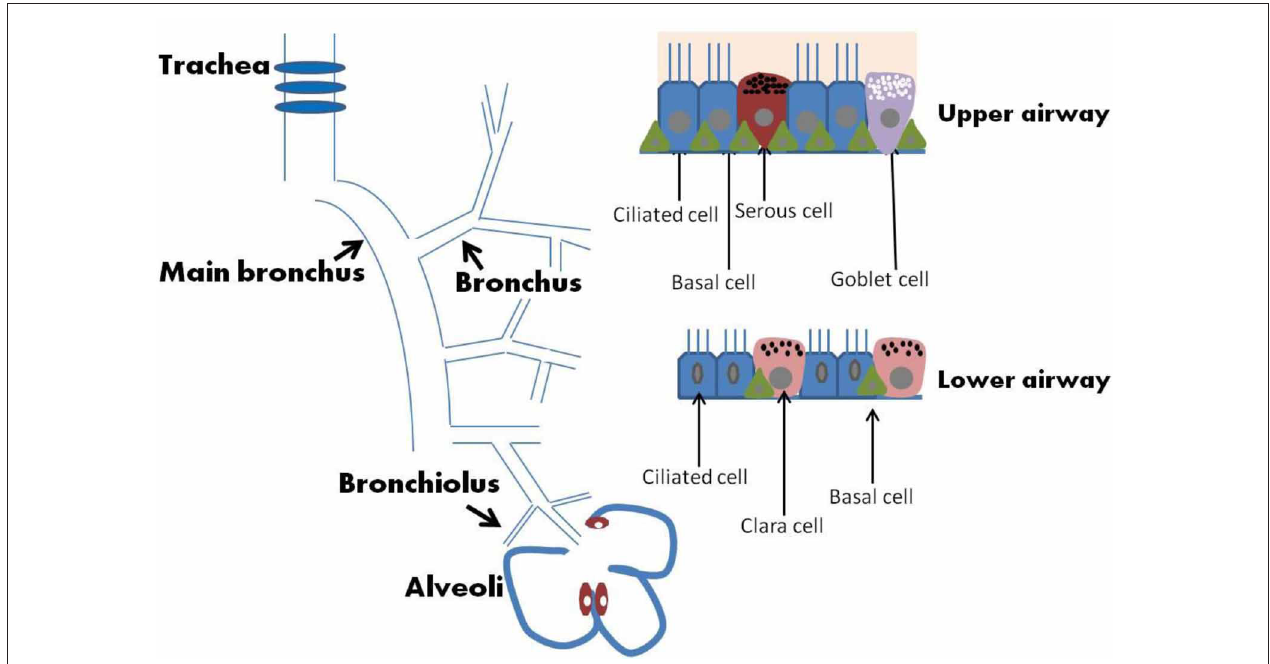
FIGURE 1 | Airway and epithelium.